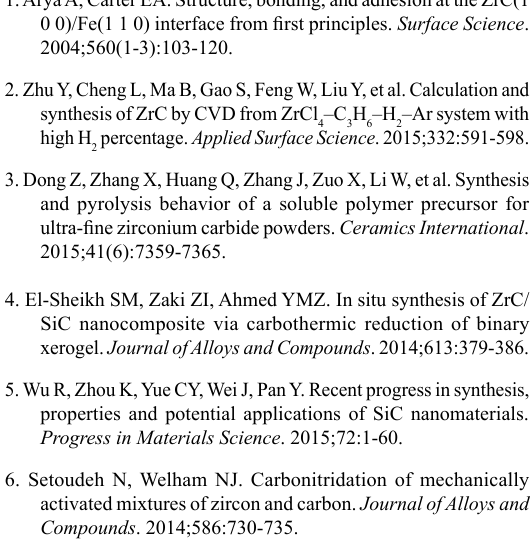
Figure 3. SEM micrographs of ZrC-SiC powders prepared at 3 kW for (a) 40, (b) 50 and (c) 60 min, respectively.